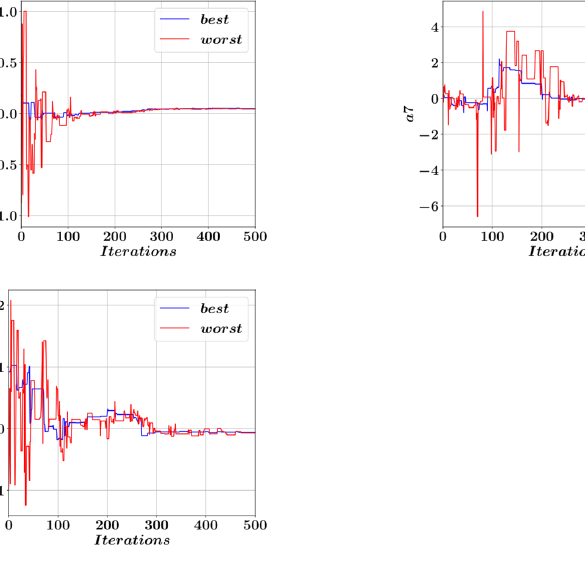
Figure 11. Development of the equation coefficients in Equation (7).